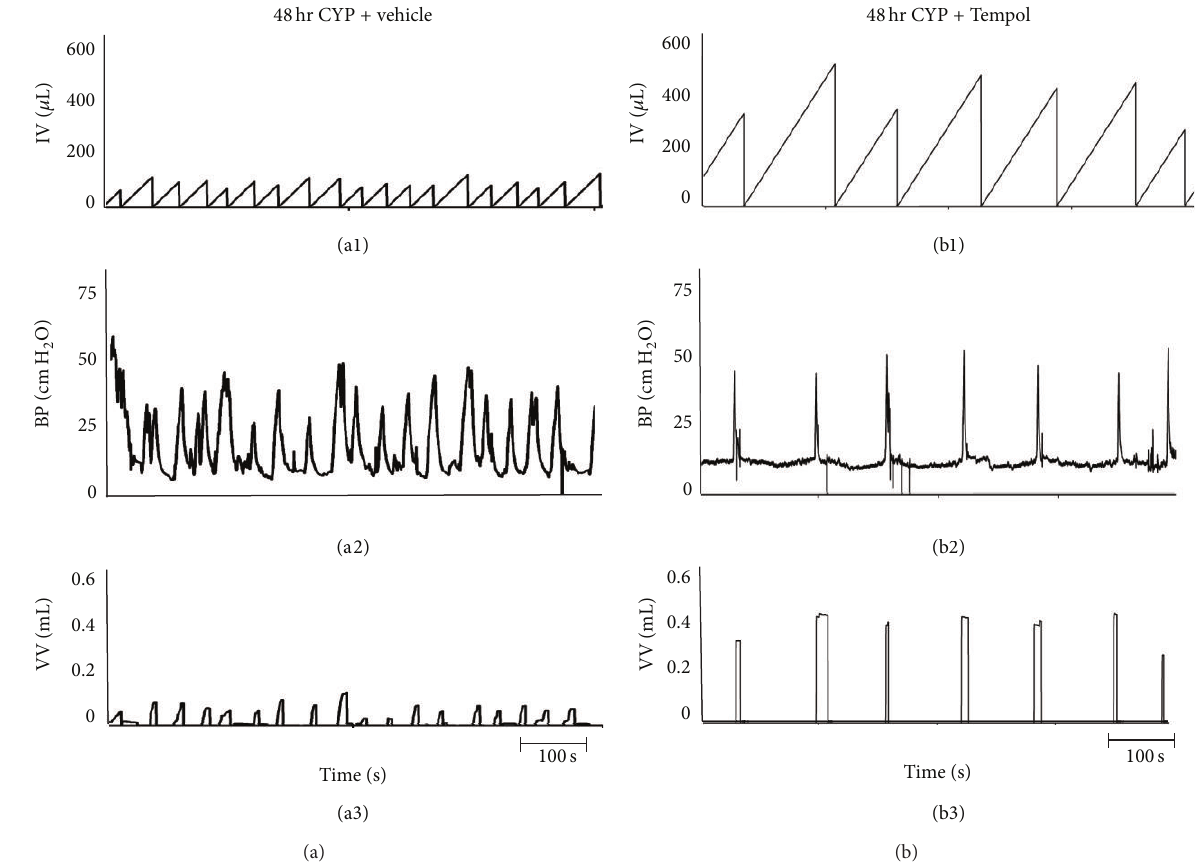
Figure 8: Representative cystometrogram recordings using continuous intravesical infusion of saline in conscious rats with an open outlet fromaCYP-treated(48 hr)ratwithvehicle((a1)–(a3))andaCYP-treated(48 hr)ratwithTempol(1 mM;(b1)–(b3)).((a),(b))Bladderfunction in a CYP-treated (48 hr) rat without Tempol (vehicle only; (a1)–(a3)) and in a CYP-treated (48hr) rat with Tempol (1mM in the drinking water; (b1)–(b3)) during continuous intravesical infusion of saline. Bladder function recordings in (a) and (b) are from different rats. Infused volume (IF, 𝜇 L; (a1), (b1)), bladder pressure (BP, cm H 2 O; (a2), (b2)), and void volume (VV, mL; (a3), (b3)) with vehicle ((a1)–(a3)) and with Tempol treatment ((b1)–(b3)) are